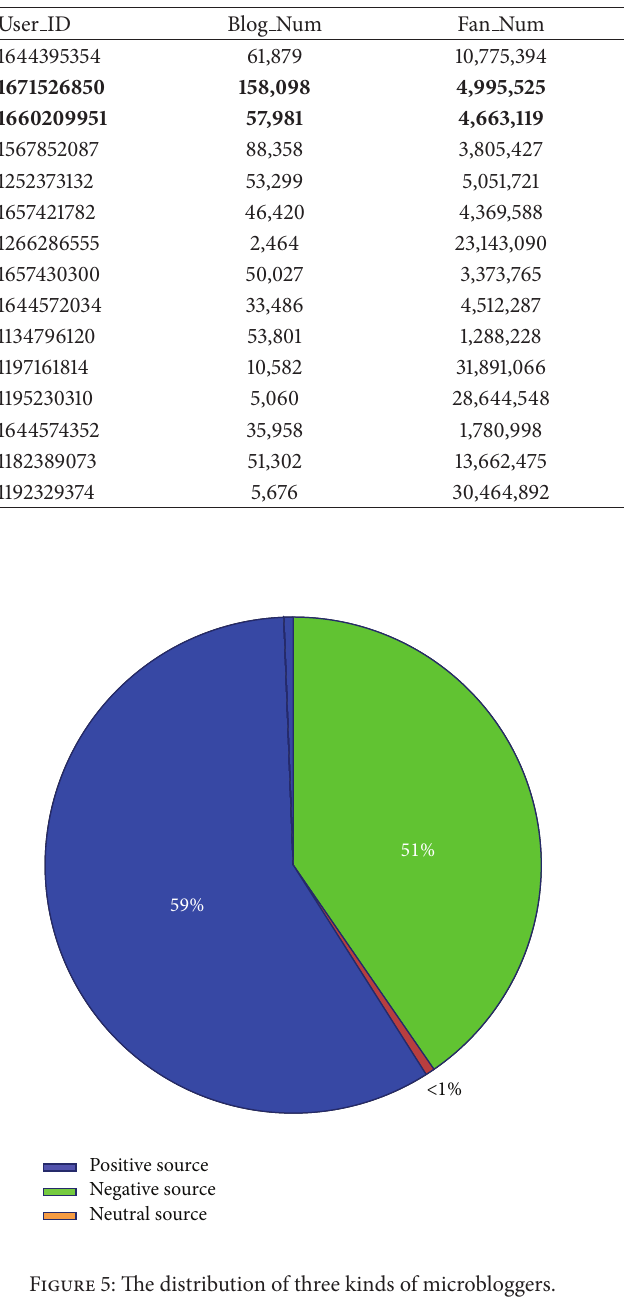
Table 2: Microbloggers whose microblogging flux is arranged in top 16.